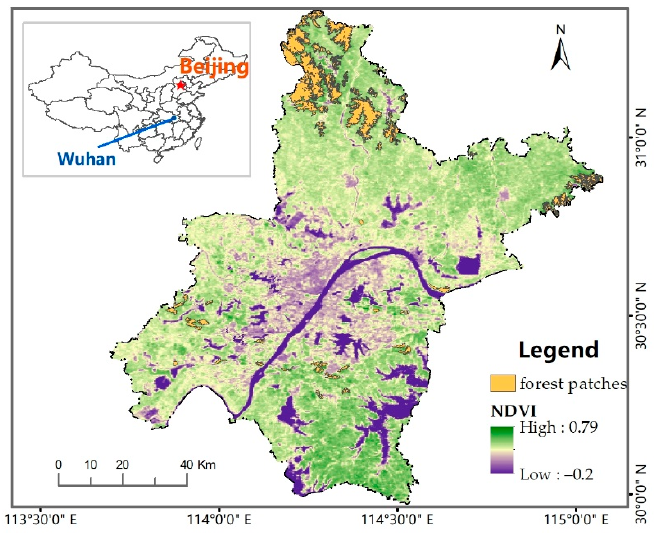
Figure 1. Distribution of the 56 forest patches and normalized difference vegetation index (NDVI) in Wuhan.